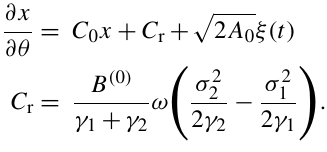
Figure 2. Left: comparison of the ensemble spread for the orig- inal additive triad system for ε = 0 . 25 from an initial condition ( − 5 , 0 , 0 ) (the ensemble mean is the blue dashed line, 2 σ inter- val is the blue shaded area), the two-level Ornstein–Uhlenbeck pro- cess from the weak coupling method (Eq. 11) from an initial condi- tion ( − 5 , 0 ) (ensemble mean: red dash-dotted line, 2 σ interval: red dash–dot-dotted lines) and the one-level Ornstein–Uhlenbeck pro- cess from homogenization (Eq. 4) from x = − 5 (ensemble mean: green solid line, 2 σ interval: dotted lines). Right: comparison of the autocorrelation functions of the slow variable (cid:104) x(t)x( 0 ) (cid:105) in the full triad for ε = 0 . 5 (blue dash-dotted line), (cid:104) z 1 (t)z 1 ( 0 ) (cid:105) in the weak coupling model (green solid line) and (cid:104) x(t)x( 0 ) (cid:105) for the homogenized equation (red dashed line). Both plots use pa- rameter values B ( 0 ) = − 0 . 75, B ( 1 ) = − 0 . 25, B ( 2 ) = 1, γ 1 = 1 /δ , √ √ σ 1 = 2 /δ , γ 2 = 1 and σ 2 = 2 with δ = 0 . 75; the ensemble size is